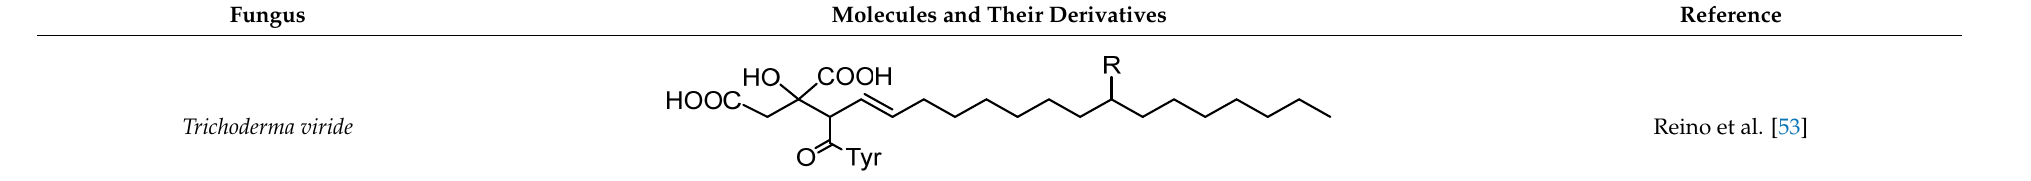
Table 1. Secondary metabolites found in fungi of the genus Trichoderma with anti-melanogenic effect. Structures of tyrosinase inhibitors from Trichoderma